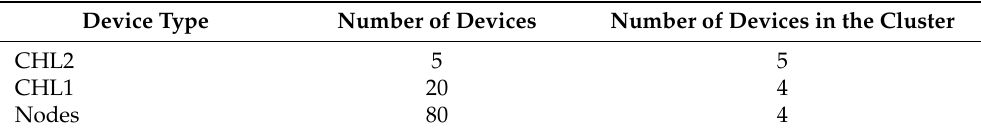
Table 4. Device types and numbers in a hypothetical IoT network.